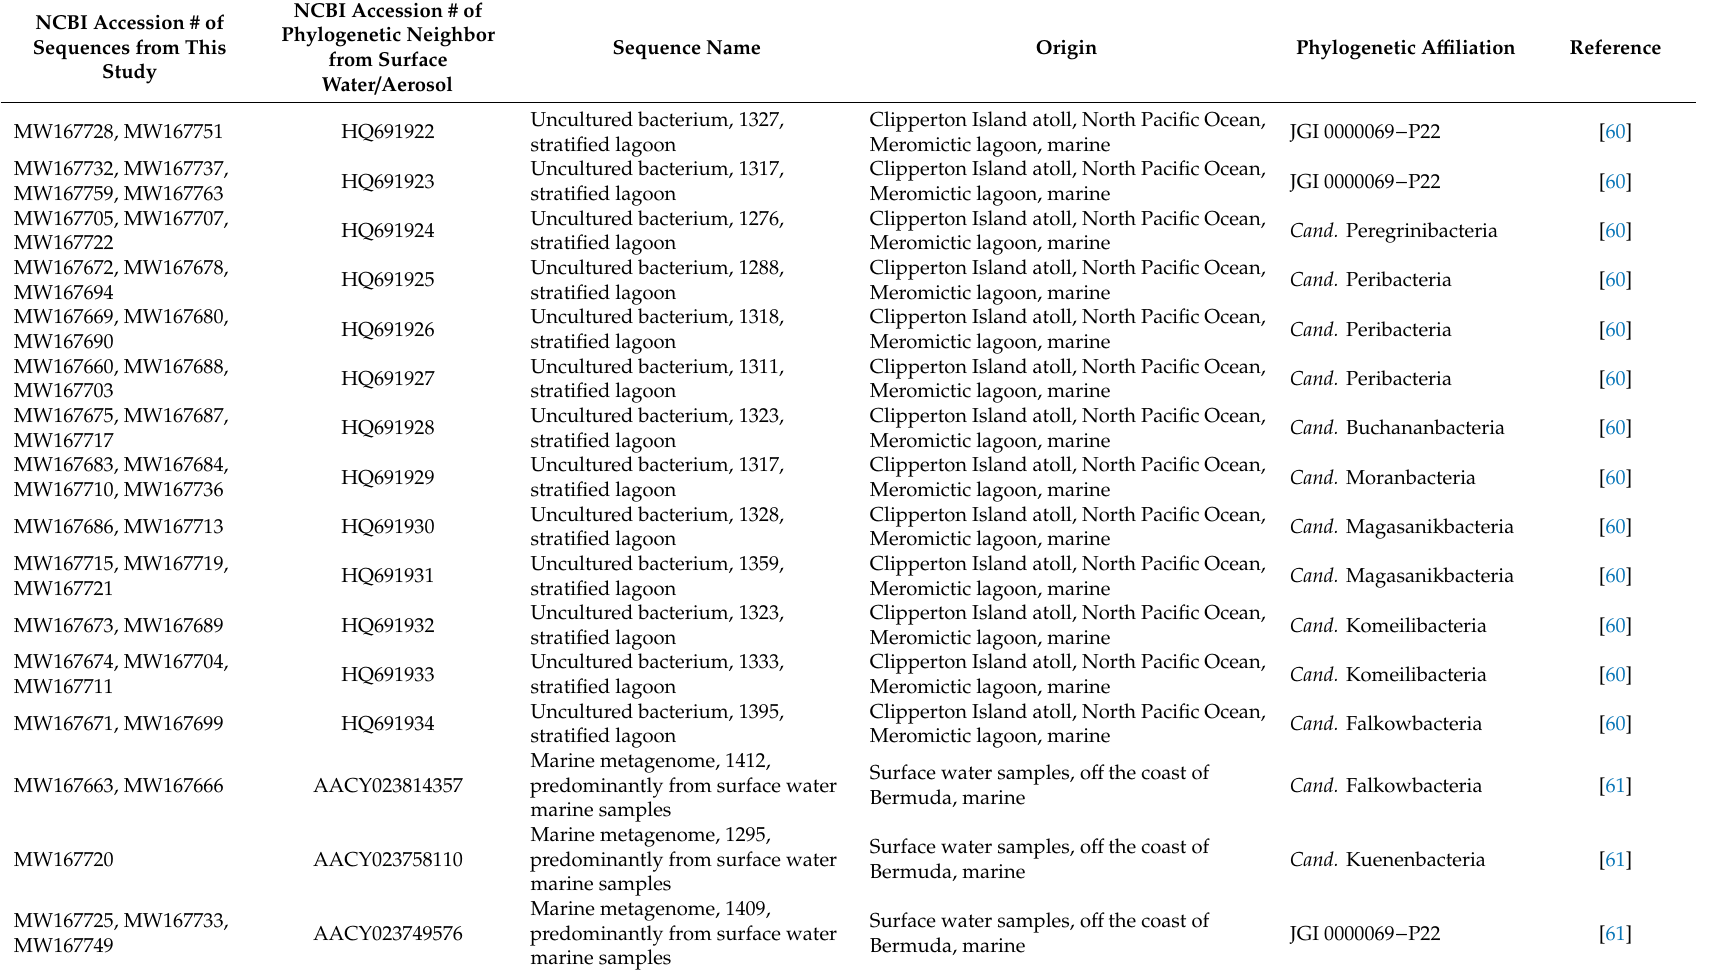
Table 1. Sequences related to Cand. Patescibacteria of marine surface water or atmospheric origin. Sequences were detected based on phylogenetic clustering with samples from this